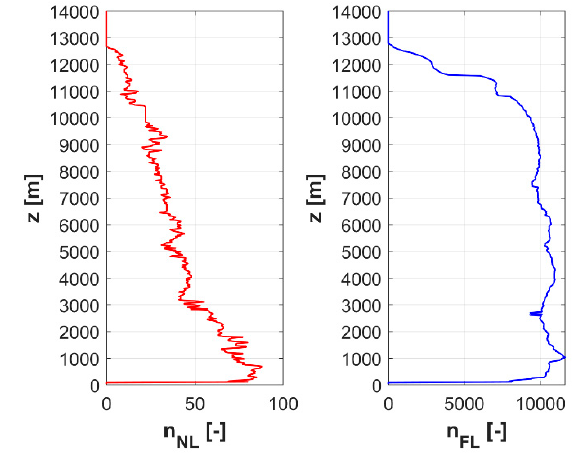
Figure 9 Number of examined cases of NL (left) and FL (right) with available LDR at gates. Y-axis represents the height [m] above the cloud radar situated at an elevation of 837 m a.s.l.